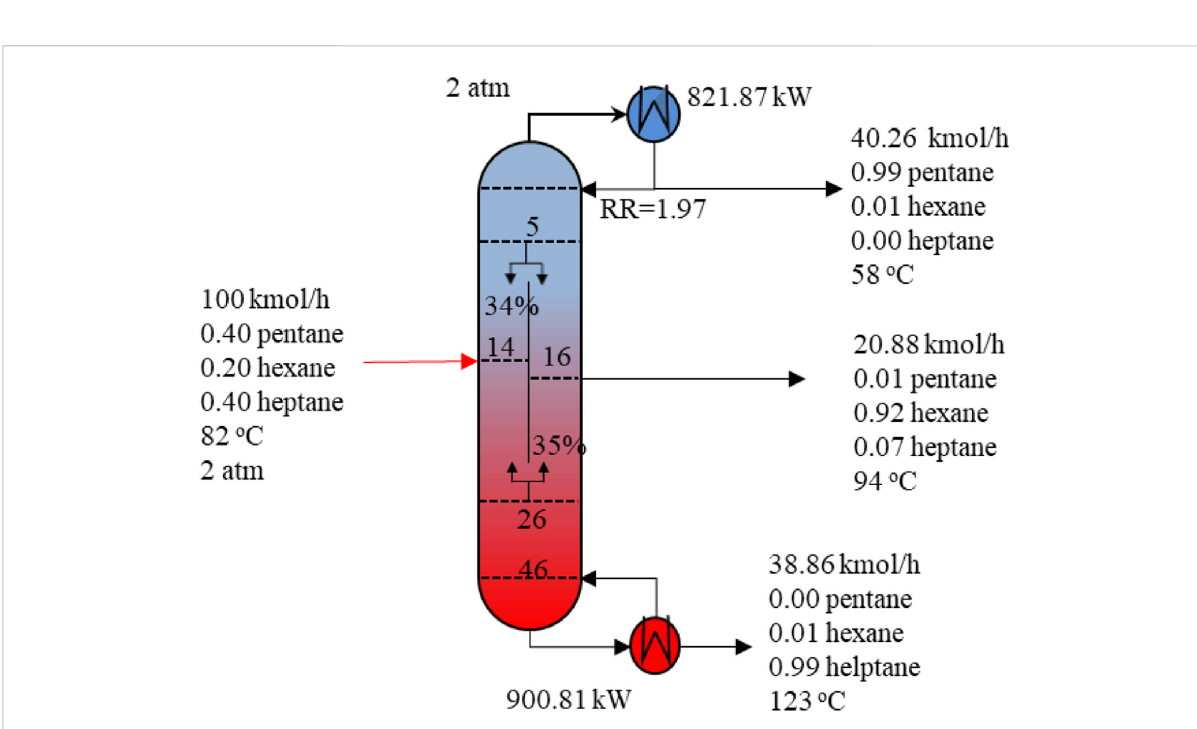
FIGURE 5 Optimal design and operating conditions of DWC column for Example